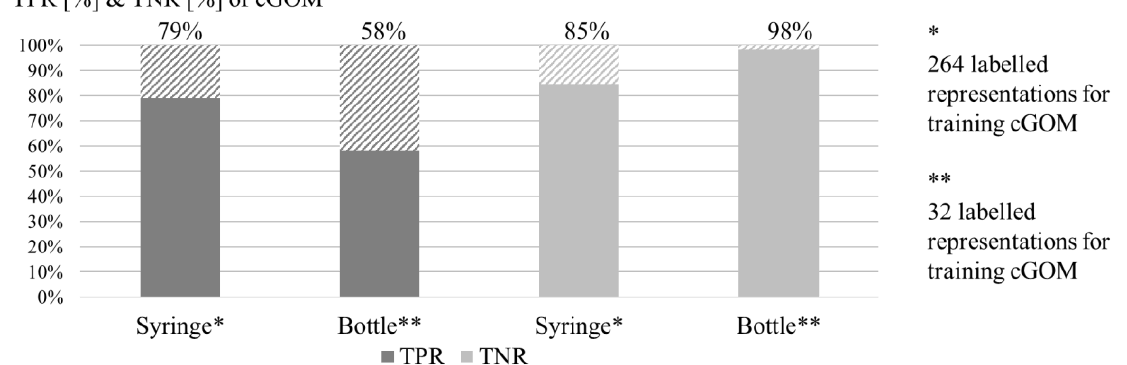
Figure 4: True positive rate (TPR) and true negative rate (TNR) of the cGOM assignment, compared to the manual assignment, which is considered as ground truth [%]. Relation between the results of the manual mapping (abscissa) and the mapping by the cGOM tool (ordinate). 264 labelled representations for the AOI syringe, and 32 labelled representations for the AOI bottle were used for training the cGOM